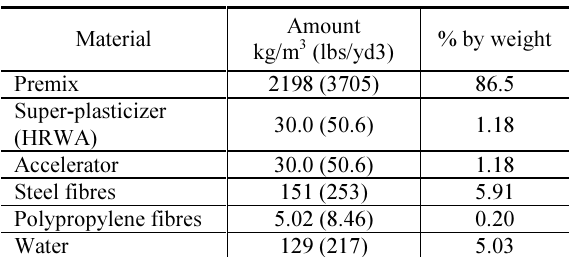
Table 1. Composition of UHPFRC